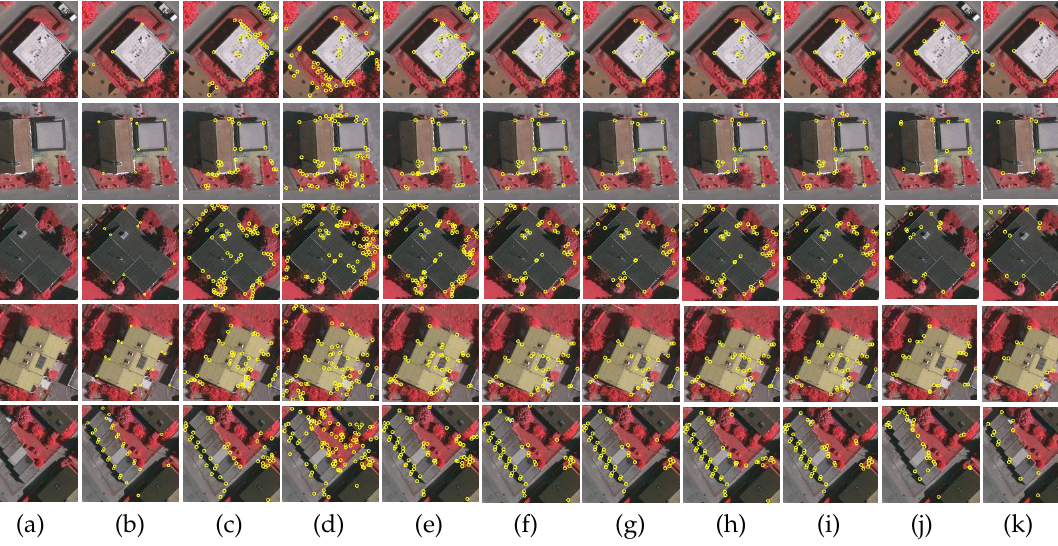
Figure 10. Performance comparison of different corner detectors. ( a ) Test images; ( b ) ground-truth corner points; ( c ) the ANDD [8]; ( d ) the CPDA [27]; ( e ) the CSS [5]; ( f ) the fast CPDA [28]; ( g ) the GCM [30]; ( h ) the He & Yung [29]; ( i ) the WEAE [9]; ( j ) the RCF [26]; ( k ) the proposed model. Table 4. A comparison of different detectors in terms of running time (in